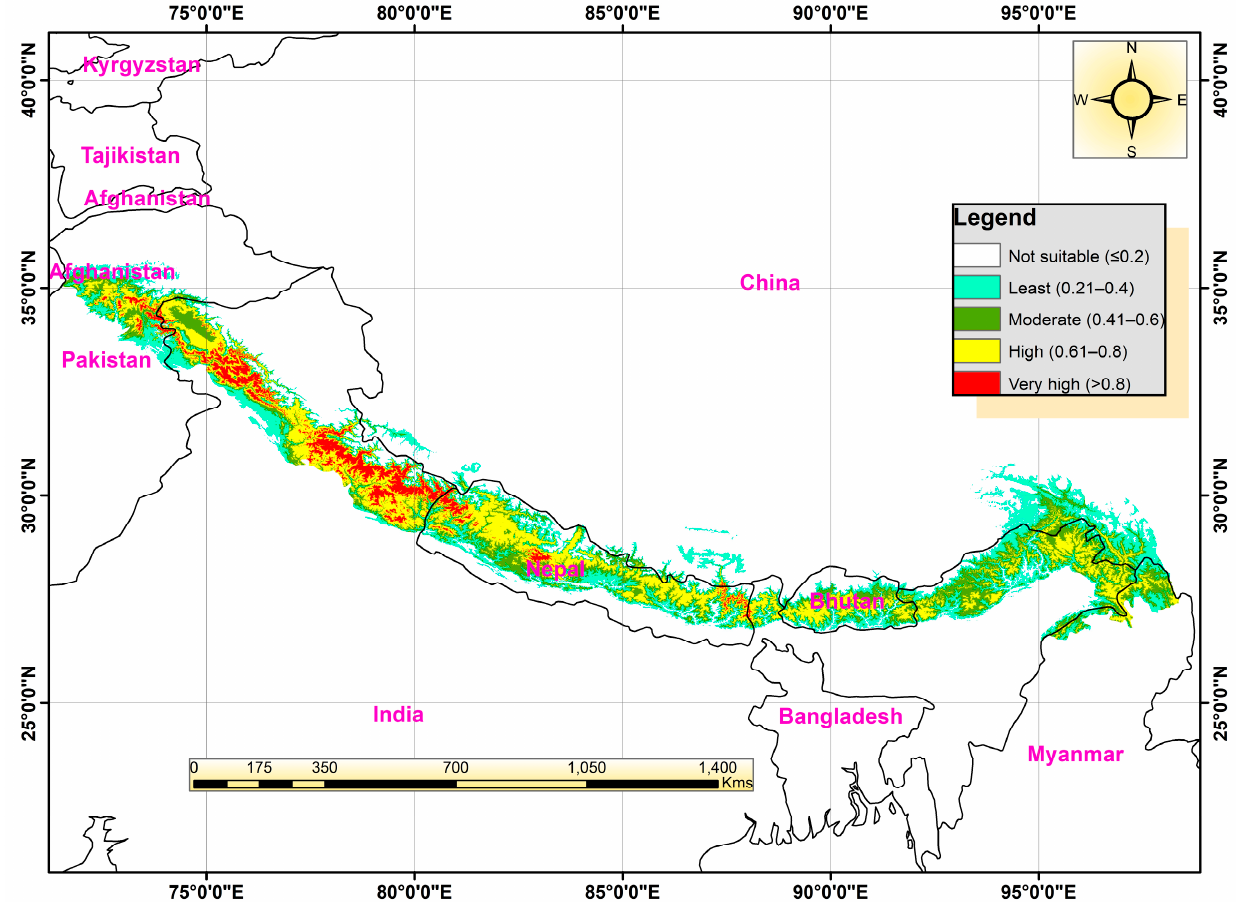
Figure 6. MaxEnt prediction map displaying the potential habitat suitability classification of Himalayan goral in the study area under current climatic (1970s–2000s) conditions.